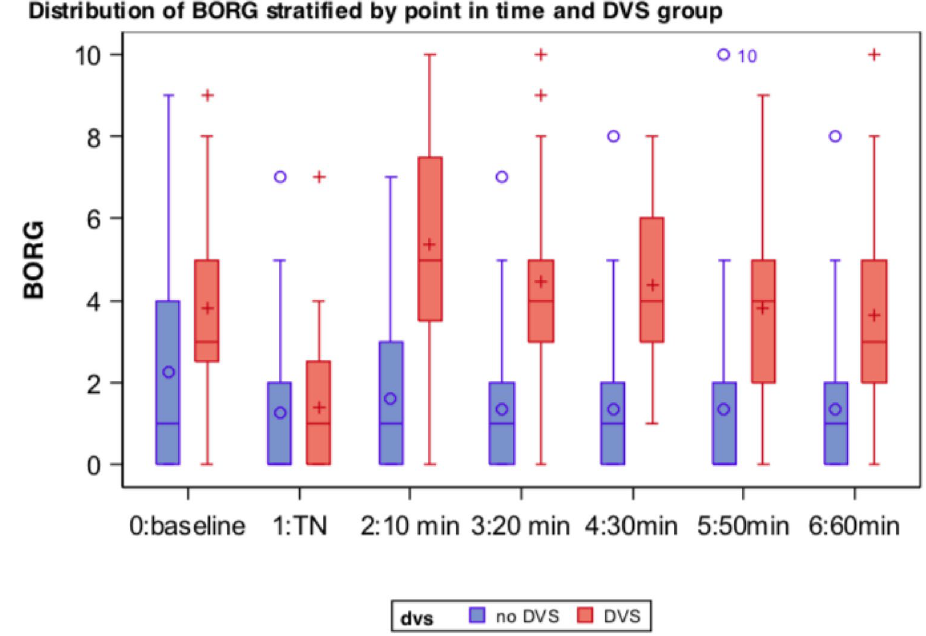
Figure 3. Borg stratified by point of time and